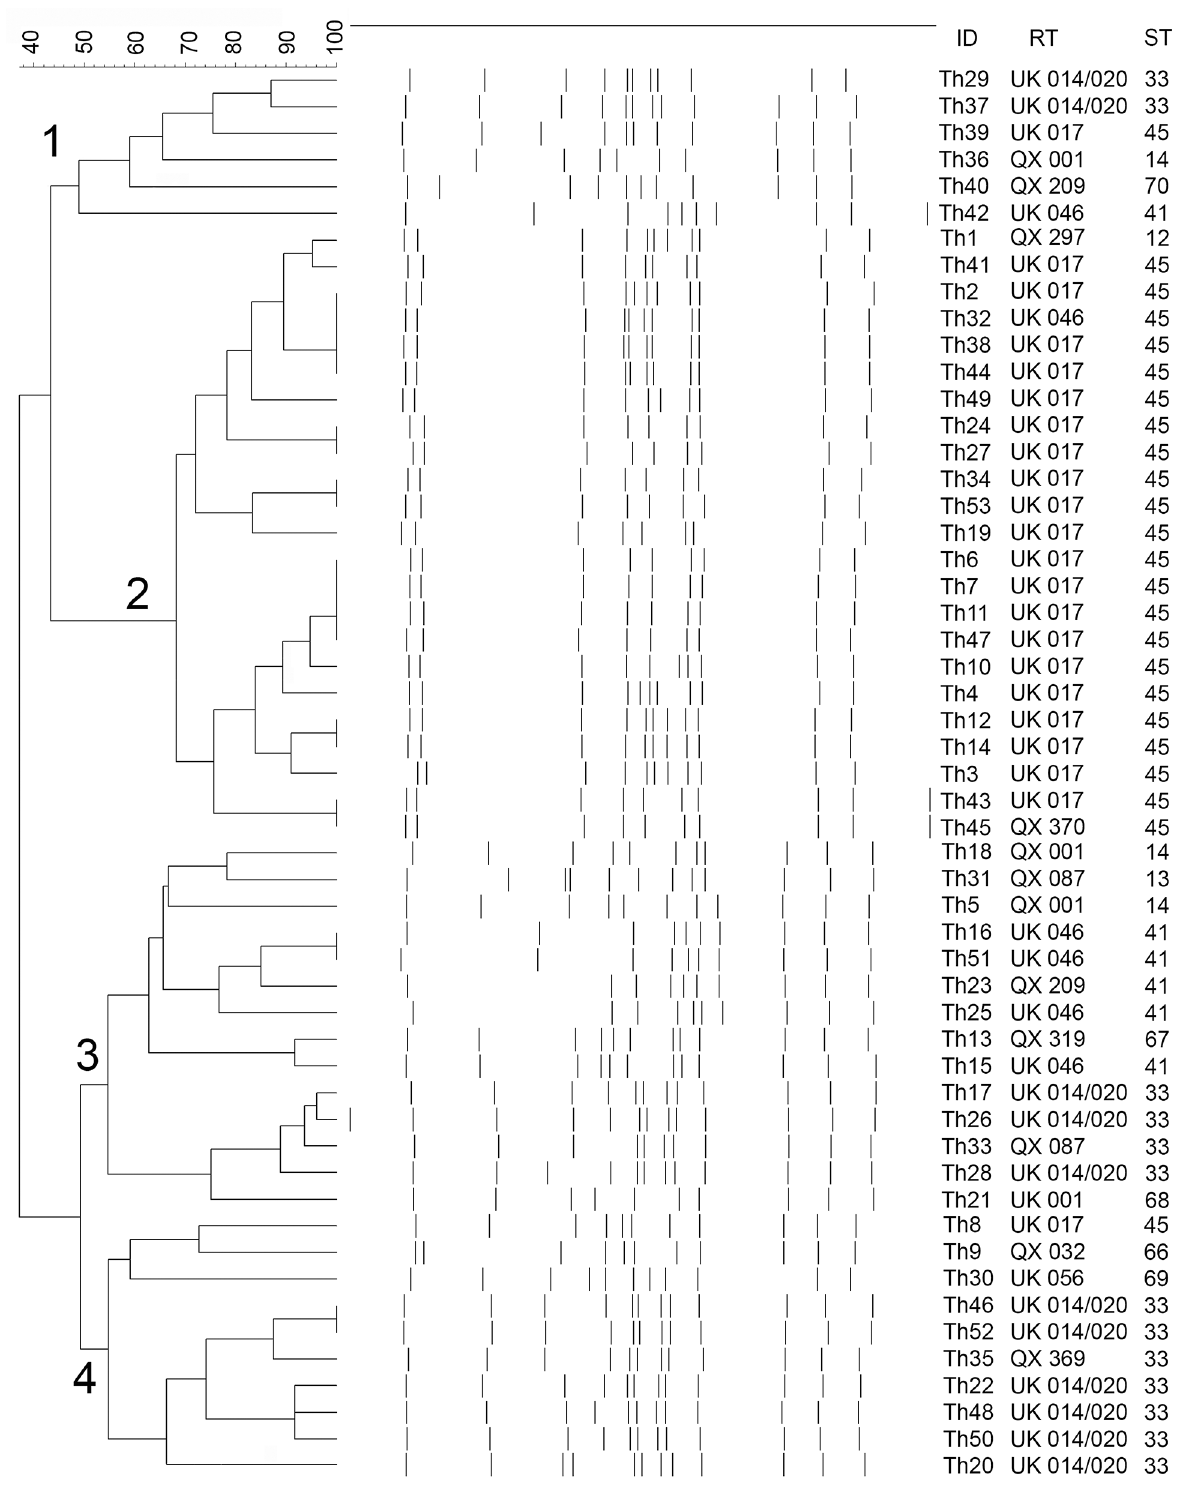
Fig 1. Dendrogram showing PFGE types and their correlations with RTs and STs. Numbers on the branches represent PFGE types. ID = strain identity; RT = ribotype; ST = sequence type. The scale represents the percentage level of similarity.